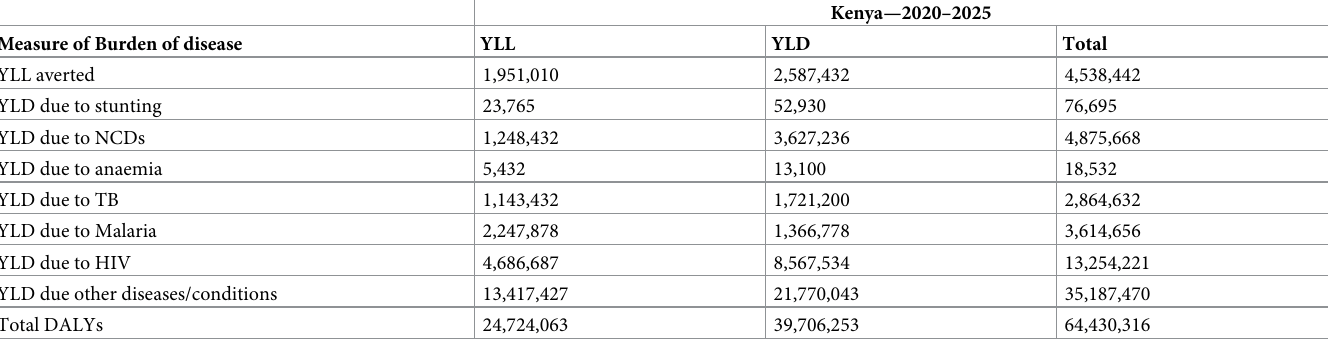
Table 4. Health impact of PHC interventions on Disability Adjusted Life Years